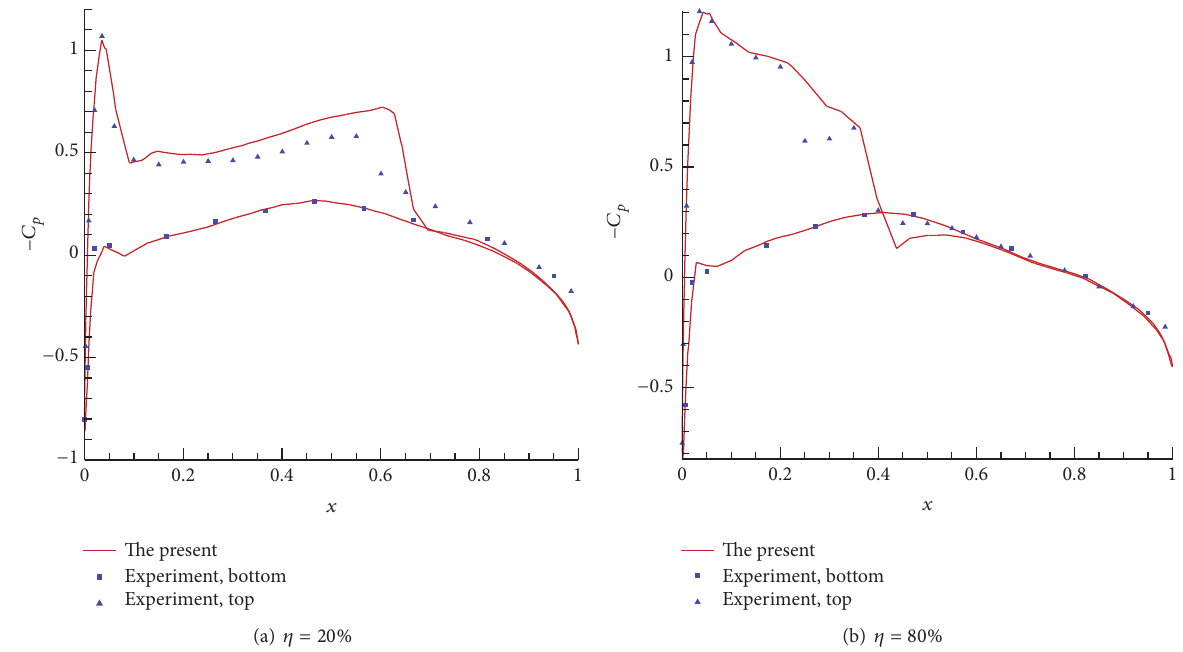
Figure 5: Comparison of section pressure coefficients of ONERA